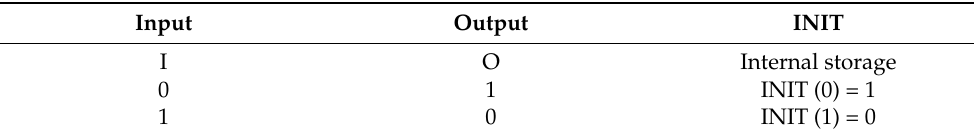
Table 2. LUT1 input/output truth